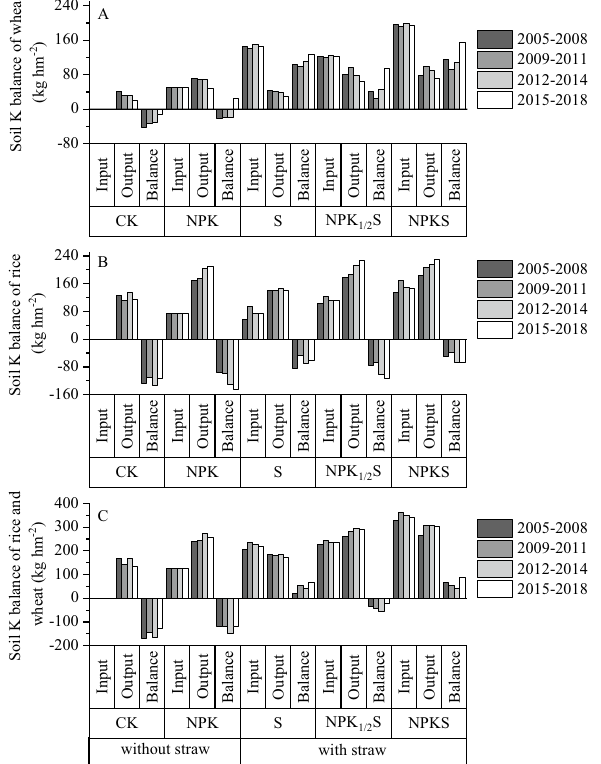
Figure 1. Characteristics of soil potassium balance for different cropping rotation periods from 2005 to 2018. (CK, no fertilization; NPK, mineral fertilizing; S, straw 6000 kg h m −2 , NPK 1/2 S, NPK with straw 3000 kg h m −2 and NPKS, NPK with straw 6000 kg h m −2